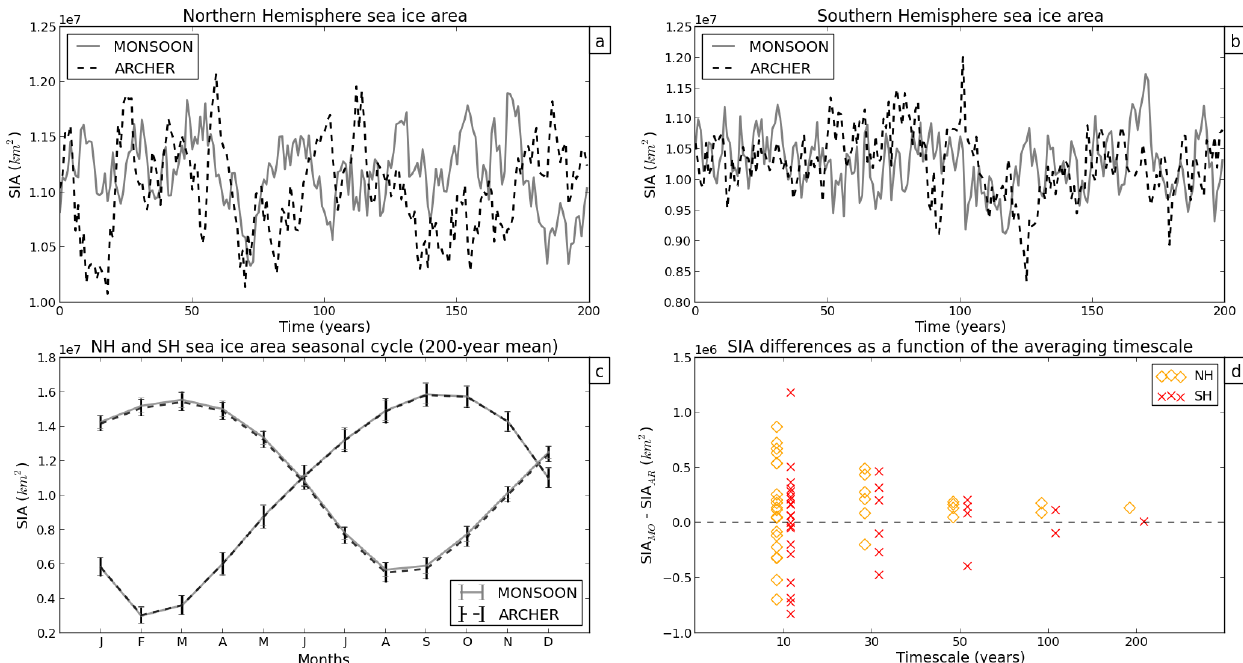
Figure 5. Annual mean time series of Northern Hemisphere SIA (a) and Southern Hemisphere SIA (b) for PI MO (grey line) and PI AR (dashed line). The 200-year mean of the NH and SH SIA seasonal cycle is shown in (c) . Panel (d) shows how SIA differences vary as a function of the